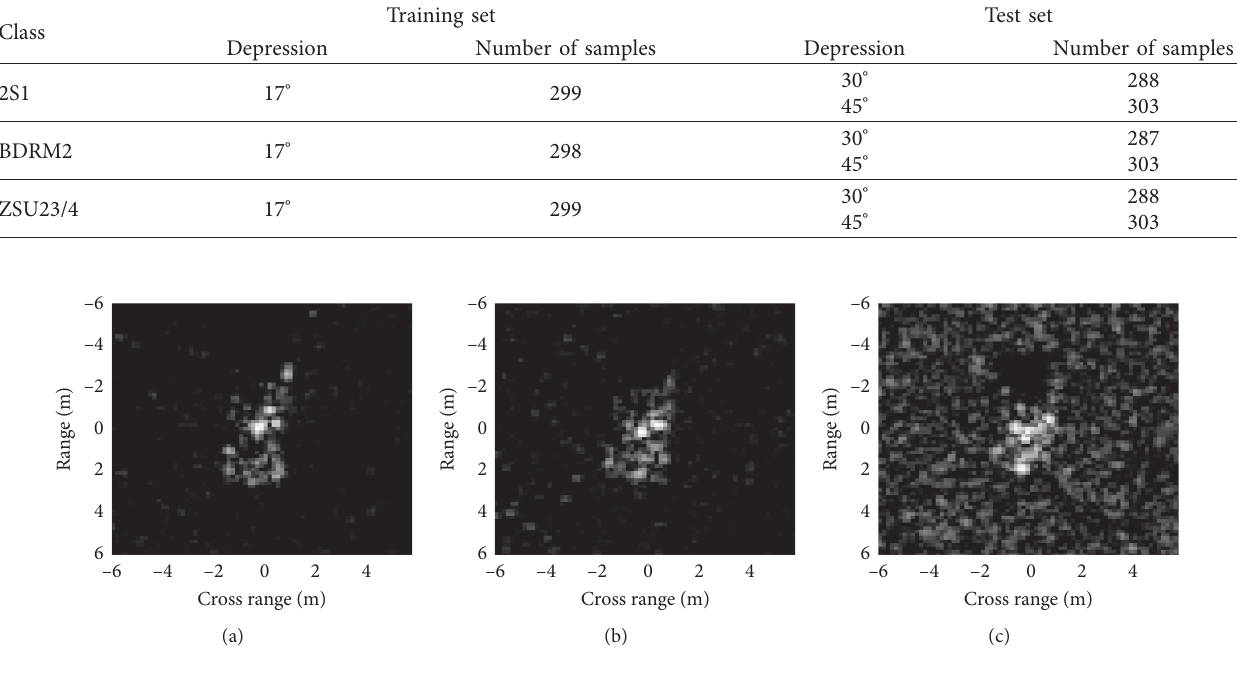
Figure 6: SAR images at different depression angles: (a) 17 ° ; (b) 30 ° ; and (c) 45 ° . Table 7: Performance of methods with regard to large depression angle variance.